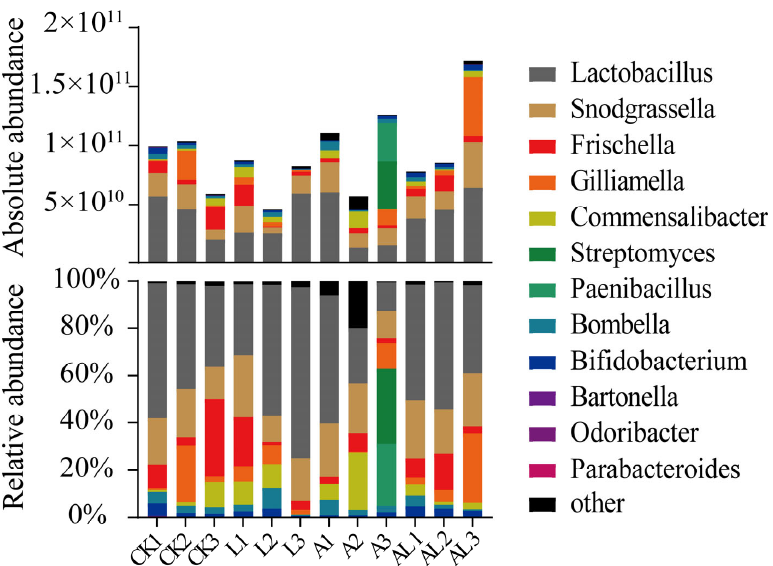
Figure 3. Relative and absolute abundances of the dominant intestinal bacteria of honeybees (genus level). Each bar represents the relative and absolute abundance of each genus in each sample. The transformed absolute abundances were total 16S rRNA gene copies transformed into relative abundance percentages, which provides a crude metric showing how the numbers of each species varied in the four groups.